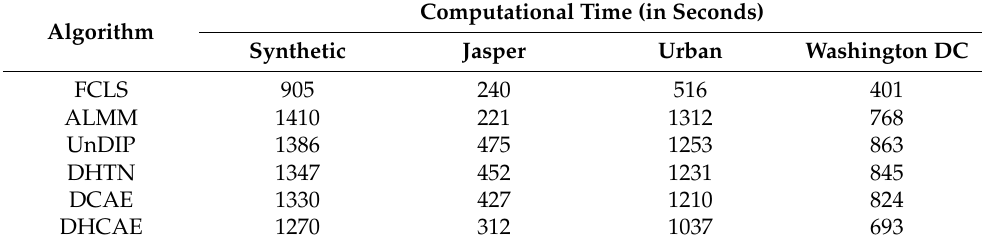
Table 7. The average time on three datasets.